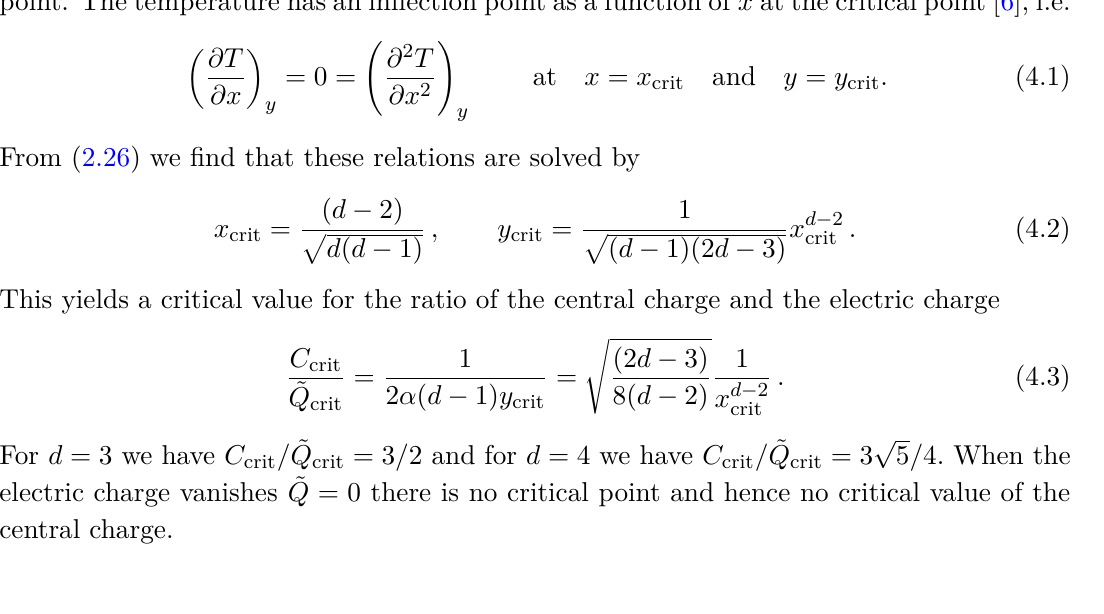
Figure 5 . Coexistence lines in d = 4 for the fixed ( high-entropy coexistence curve for CFT thermal states on ˜ Q − T phase diagram. The parameters used here are R = 1 , C = 1 / 10 (blue), C = 1 (red, dashed) and C = 10 (green, dotted). For each value of C , the coexistence line represents a line of first-order phase transitions between low-entropy states (to the left of the line) and high-entropy states (to the right), and the line ends at a critical point where a second-order phase transition occurs at ˜ Q = ˜ Q coexistence curve of the low- and high-entropy CFT states exists in the 1 /C − T phase diagram, which we depicted here for R = 1 and ˜ Q = 1 / 2 (green), ˜ Q = 2 (orange, dashed) and ˜ Q = 6 (blue,